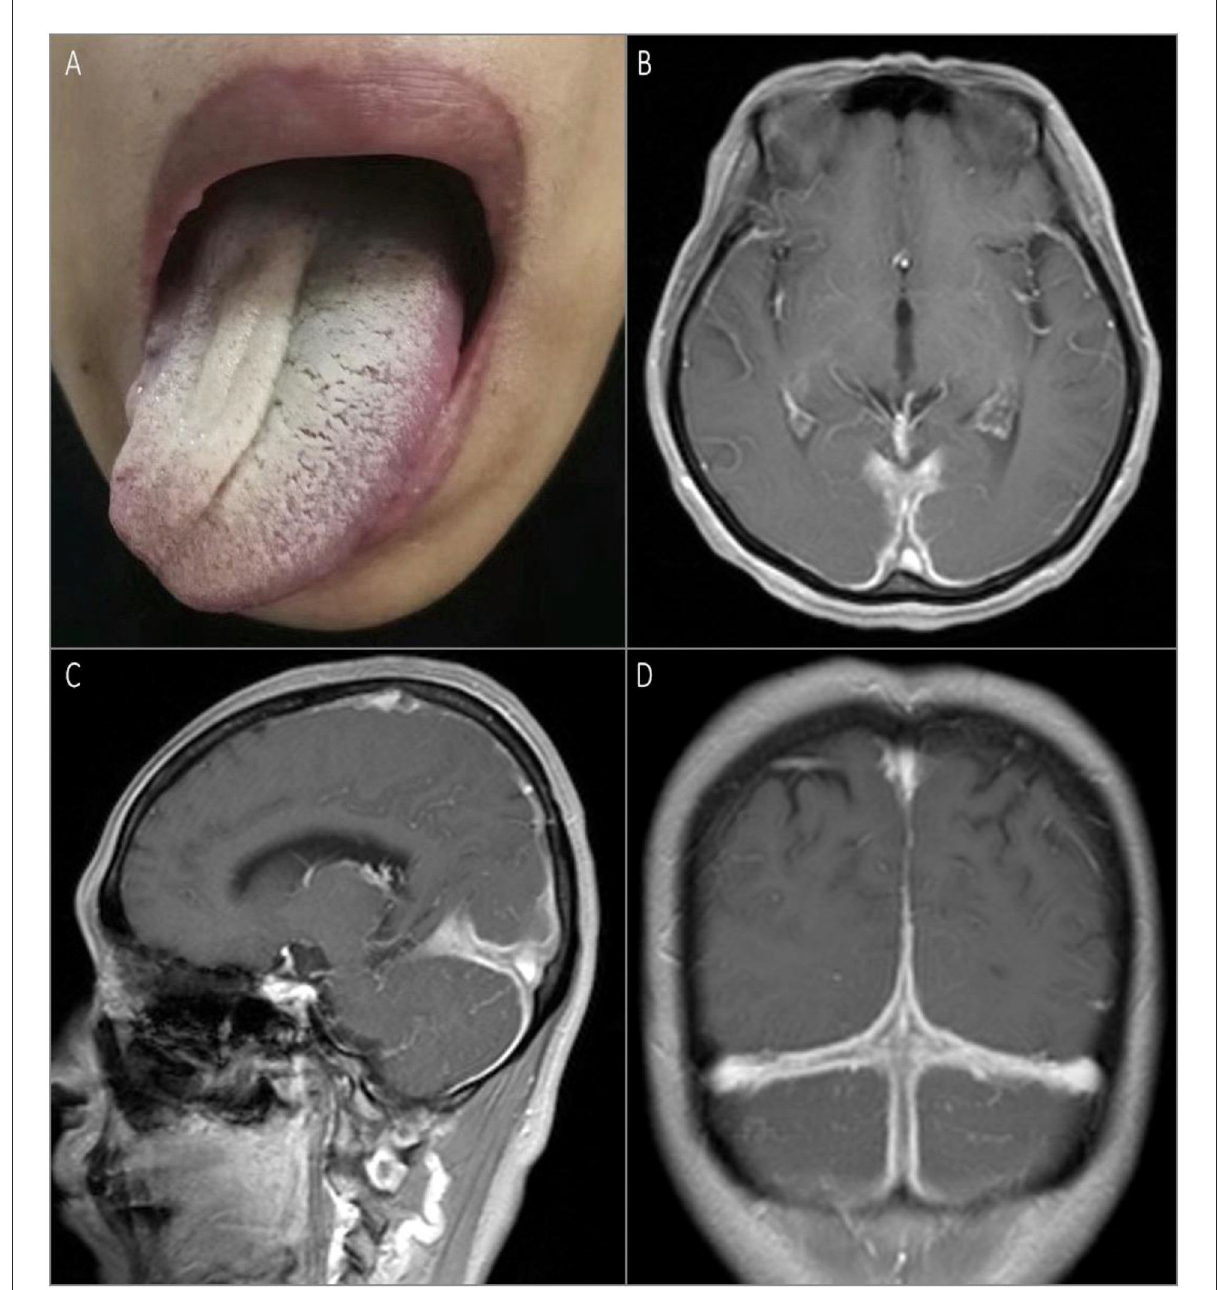
FIGURE2 Physical examination and MRI scan of the brain on admission. Rightward tongue deviation upon protrusion and atrophy of right lingualis were observed on examination (A) . T1-weighted gadolinium-enhanced brain MRI showed pachymeningeal enhancement and thickening predominantly in the posterior fossa and bilateral posterior cerebral hemispheres (B–D)